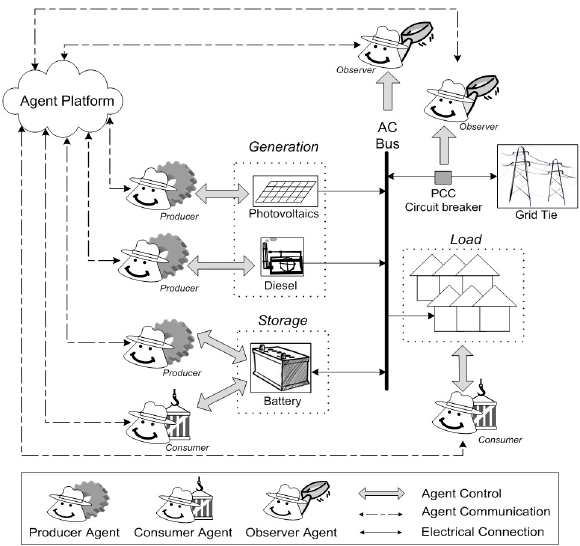
Figure 7. A decentralized agent-based controlled MG.